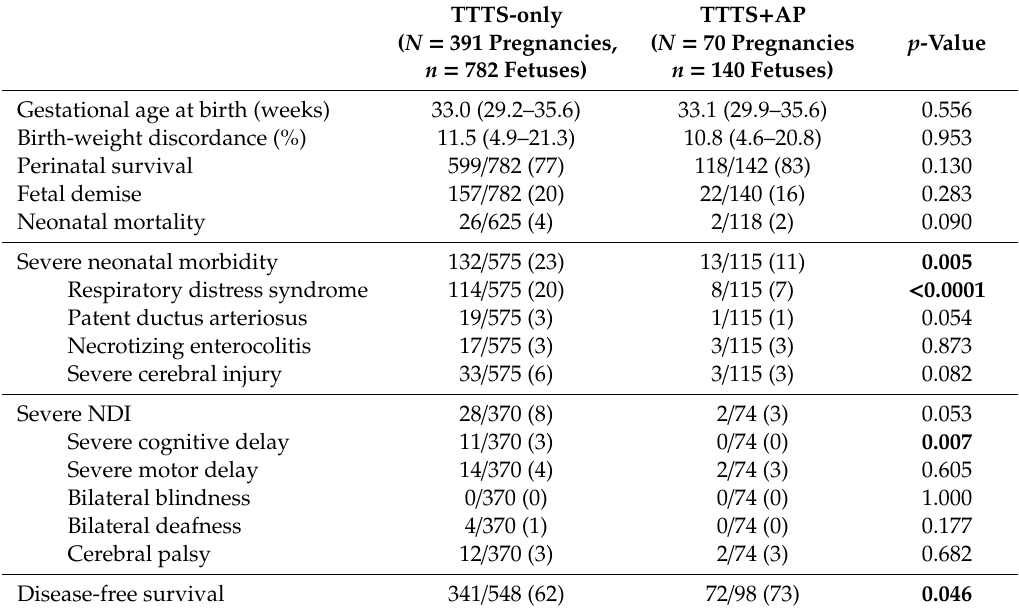
Table 3. Perinatal outcome for twins with TTTS-only and TTTS + AP